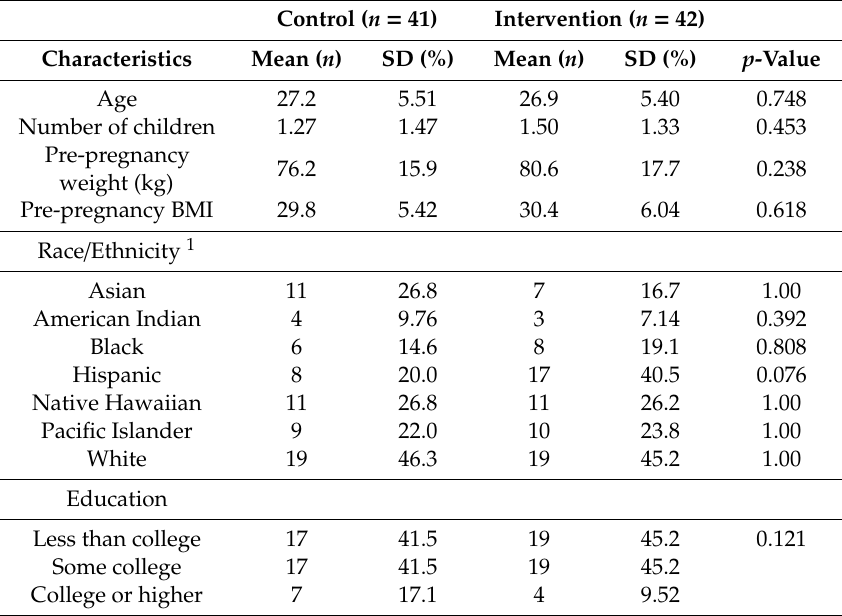
Table 2. Baseline characteristics of the sample.